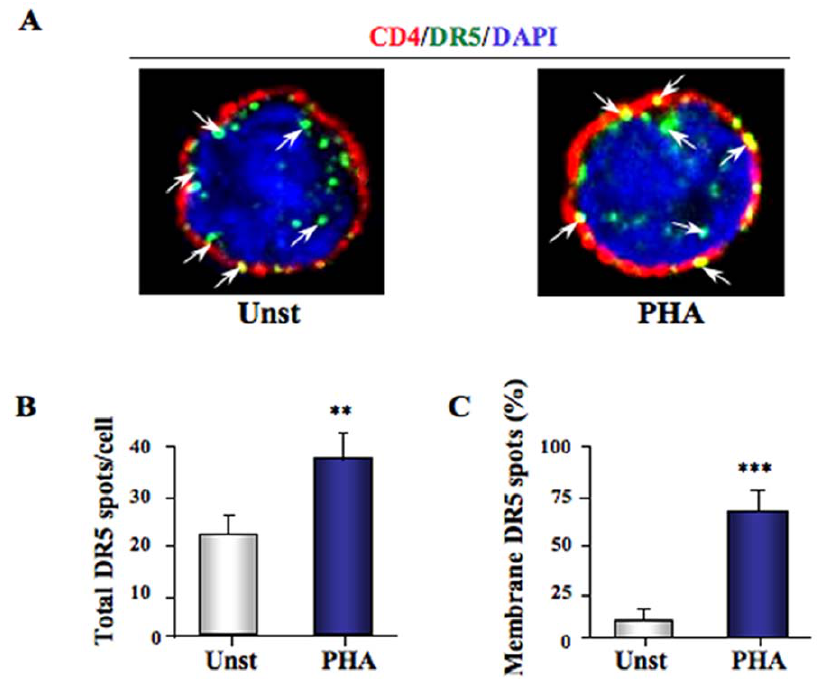
Figure 4. 3D microscopy quantification of DR5 expression by CD4 + T cells. A. CD4 + T cells were cultured overnight in presence or absence of PHA (2.5 m g/ml) and stained for DR5 (green), nuclear staining DAPI (blue) and CD4 (red) to study DR5 protein expression and localization. 10 cells per experiment were quantified for their DR5 spot number in 3 independent experiments for a total of 30 cells per condition (untreated or PHA- stimulated). White arrows show some examples of the DR5 spots that were counted B. Total number of DR5 spots in 30 untreated and 30 PHA- stimulated cells. Results show the number of DR5 spots per cell C. Percentage of membrane DR5 expression in 30 untreated and 30 PHA-stimulated cells. P values ( p ) were determined using a two-tailed Student’s t test (p , 0.05 one star, p , 0.01 two stars, p , 0.001 three stars).